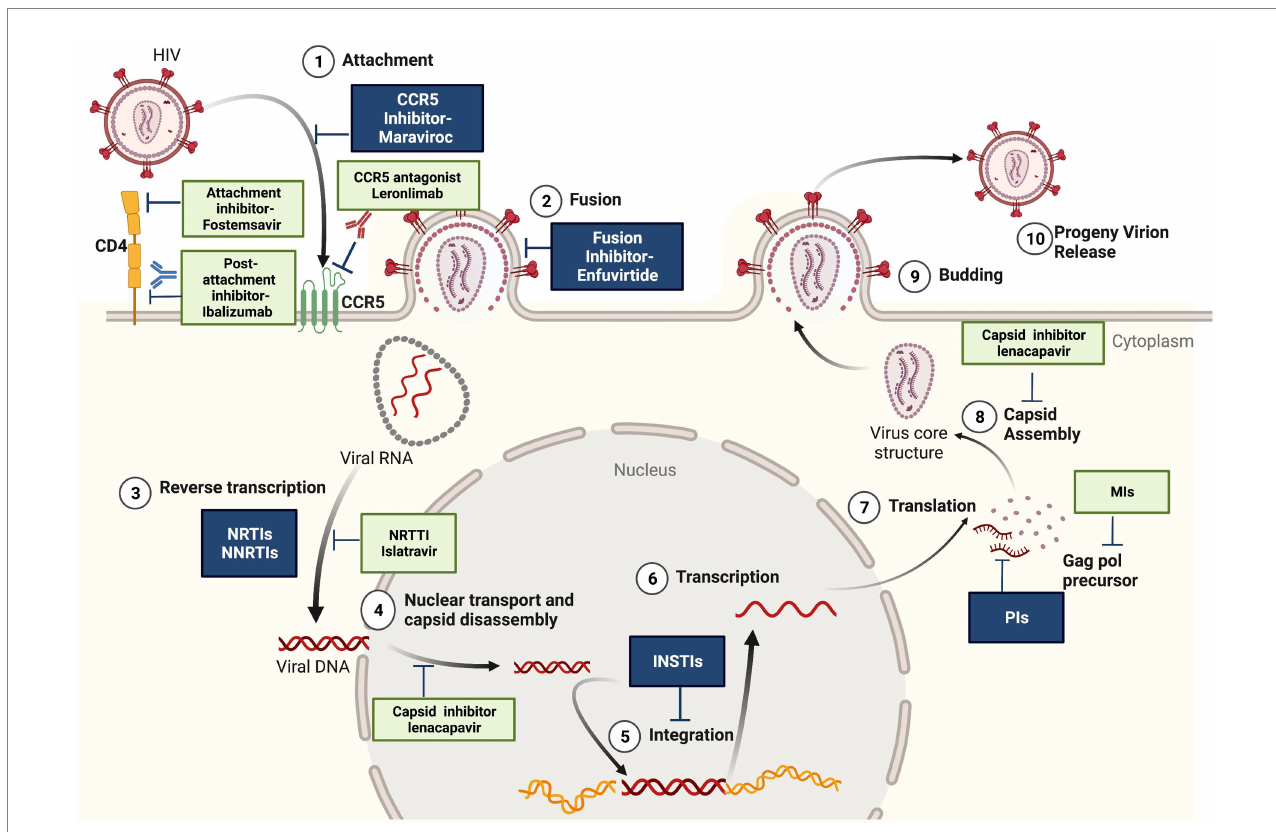
FIGURE 1 Antiretroviral agents. In dark-the conventional ART used in combinations: entry inhibitors, reverstranscription inhibitors (NRTI-nucleoside analogs reverstranscriptase inhibitors and NNRTI-non-nucleoside reverstranscriptase inhibitors), INSTI-integrase inhibitors, PI-protease inhibitors. In light color- newly approved antiretrovirals-fostemsavir (CD4 attachement inhibitor), ibalizumab (mAb gp120 post attachment inhibitor), lenacapavir (capsid inhibitor) and antiretrovirals in advanced clinical trials: leronlimab (mAb CCR5 antagonist), islatravir (NNRTTI-nucleoside reverstranscriptase translocation inhibitor) and maturation inhibitors. Created with BioRender.com, with a license to